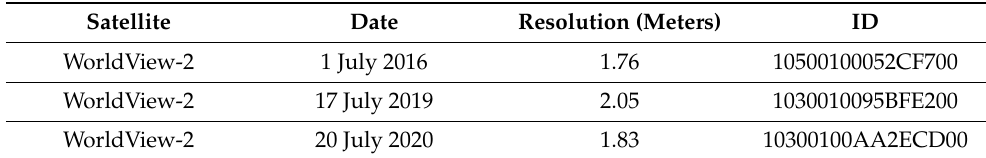
Table 1. Characteristics of satellite images utilized for